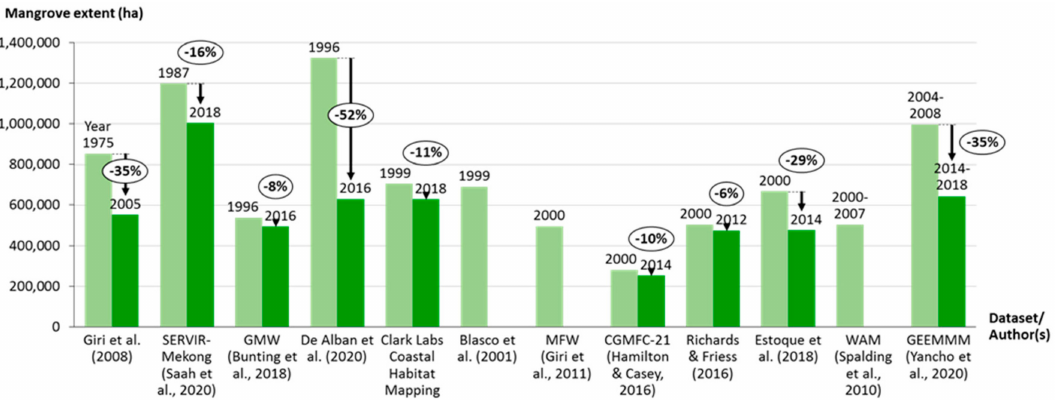
Figure 4. Comparison of distribution for all existing single- and multi-date mangrove distribution maps for Myanmar, including results of GEEEMMM pilot.